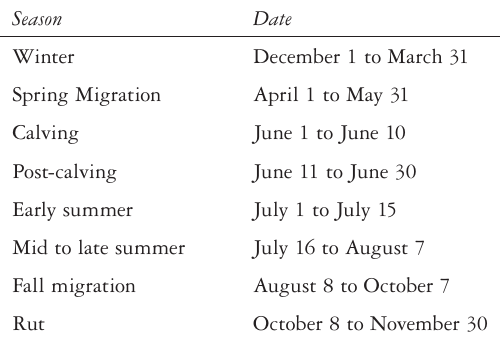
Table 1. Seasonal definitions used for the Porcupine cari- bou